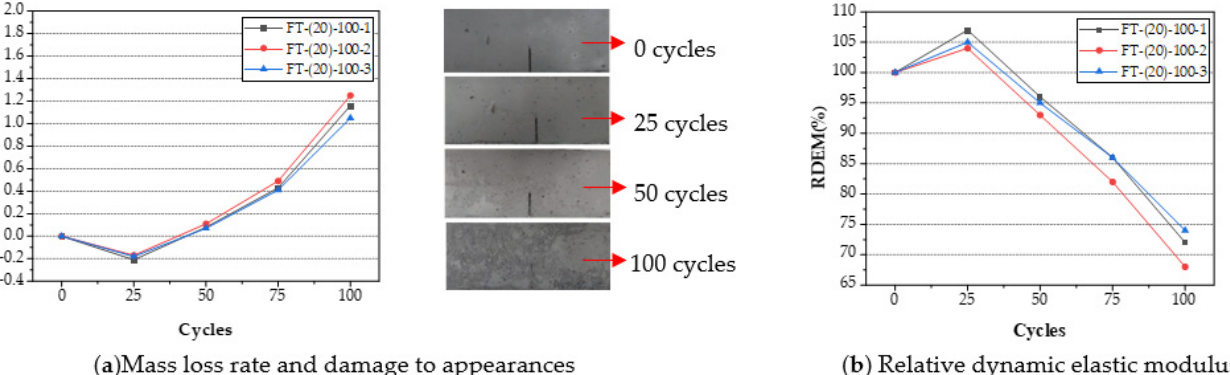
Figure 4. Changes in mass-loss rate and damage to appearances ( a ) and relative dynamic elastic modulus after n times of freeze–thaw cycles ( b ).